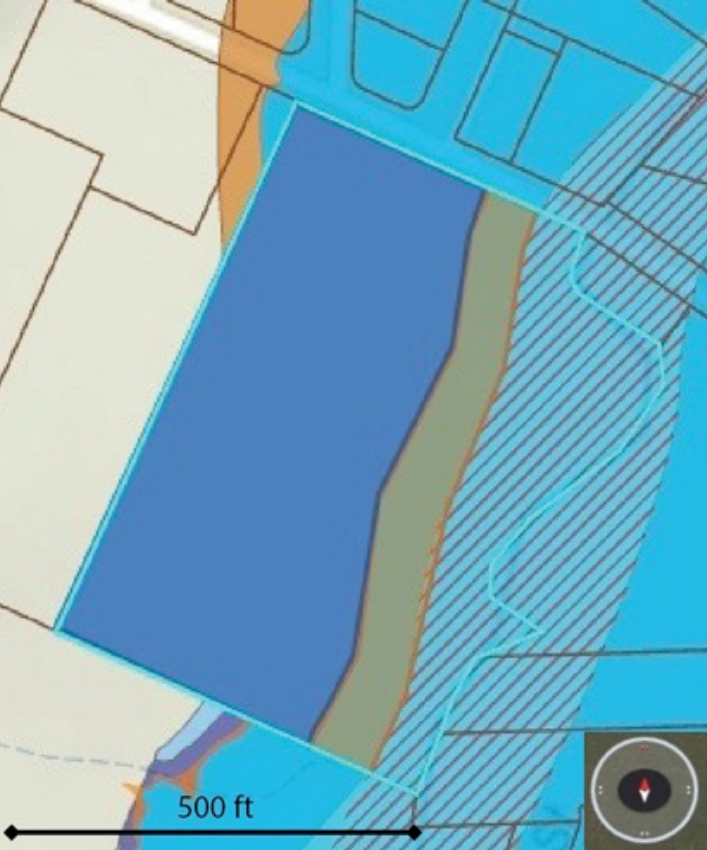
Figure 3. The three UGS zones are shown in this figure. Diagonal stripes represent the protected riparian buffer zone around the waterway. Orange represents the nature therapy and natural play transition zone. Blue represents the sports-and-recreation-dedicated area (Columbia County, OR, USA, GIS Mapping).